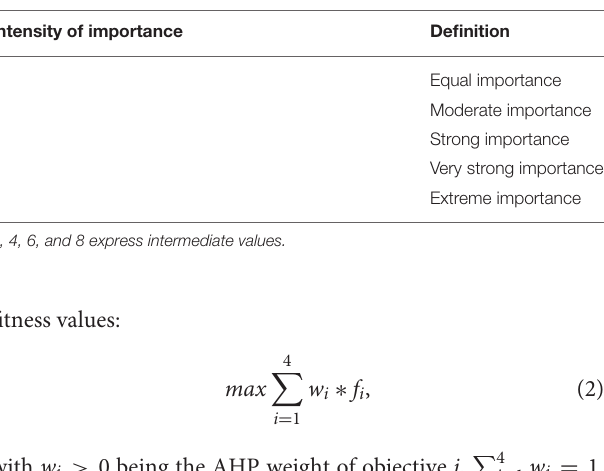
TABLE 2 | Scale of the analytic hierarchy process (AHP) (Saaty,